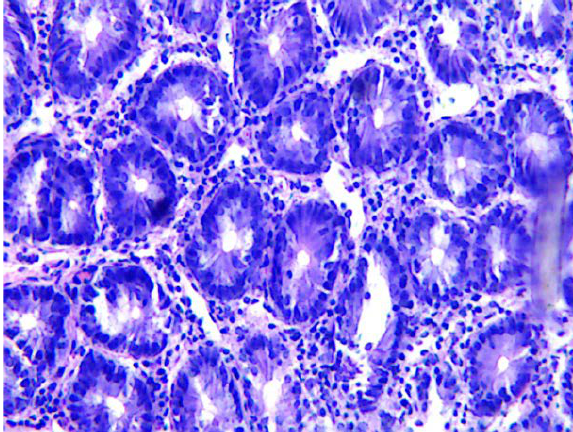
Fi gur e 2 c: Pos itiv e con t rol group.